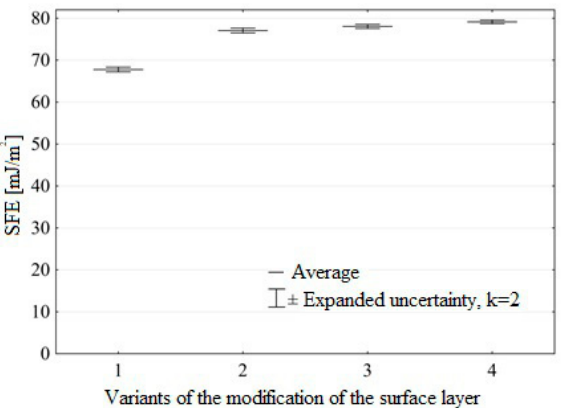
Figure 13. Surface free energy of Ti6Al4V titanium alloy for different ozone treatment conditions (modification variants of surface layer are described in “Materials and Methods”).